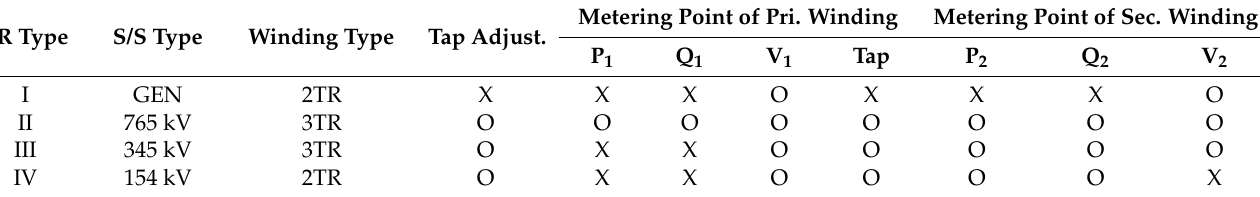
Table 3. Measurements related to the transformer in